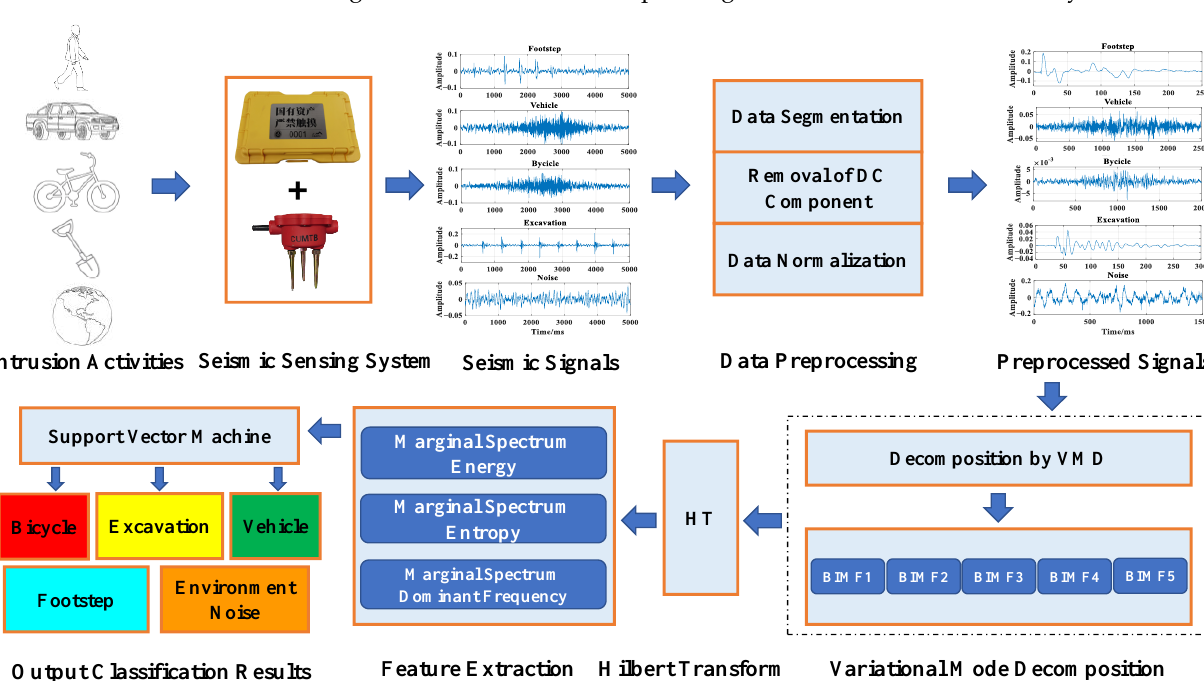
Figure 1. The algorithm flow chart of the classification for ground intrusion activities based on variational mode decomposition (VMD) and Hilbert transform (HT) time-frequency technique.